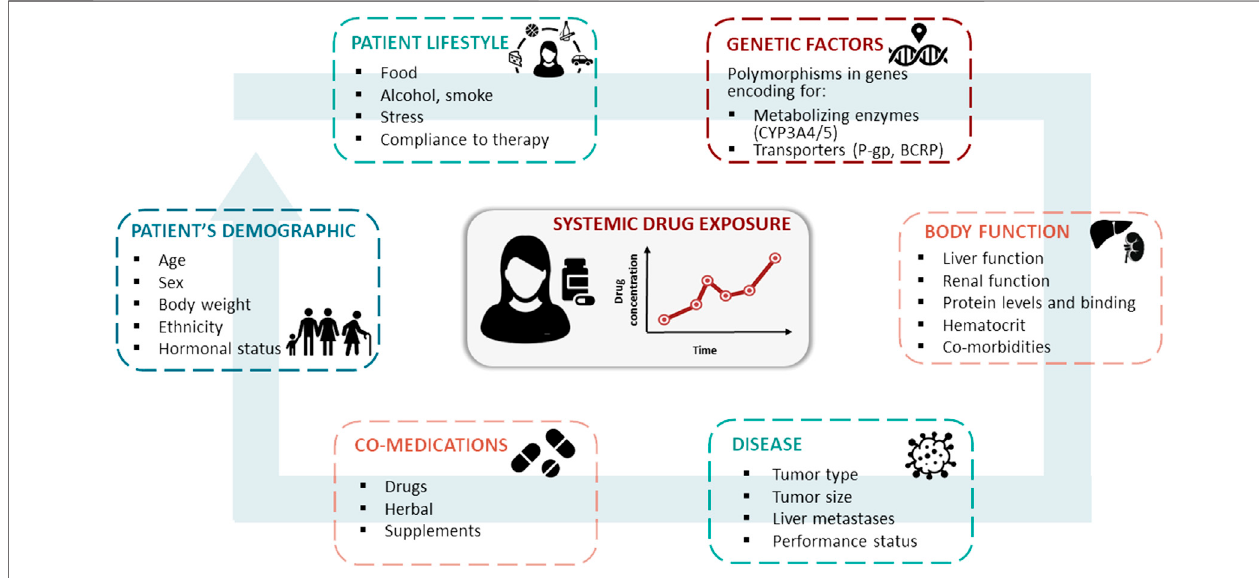
FIGURE1| Patient ’ scharacteristics,co-medications,lifestyle,geneticpro fi le,bodyfunction,anddiseasearethemainsourcesforinter-andintra-patientvariability in the pharmacokinetics of oral targeted therapies, such as CDK4/6 inhibitors.